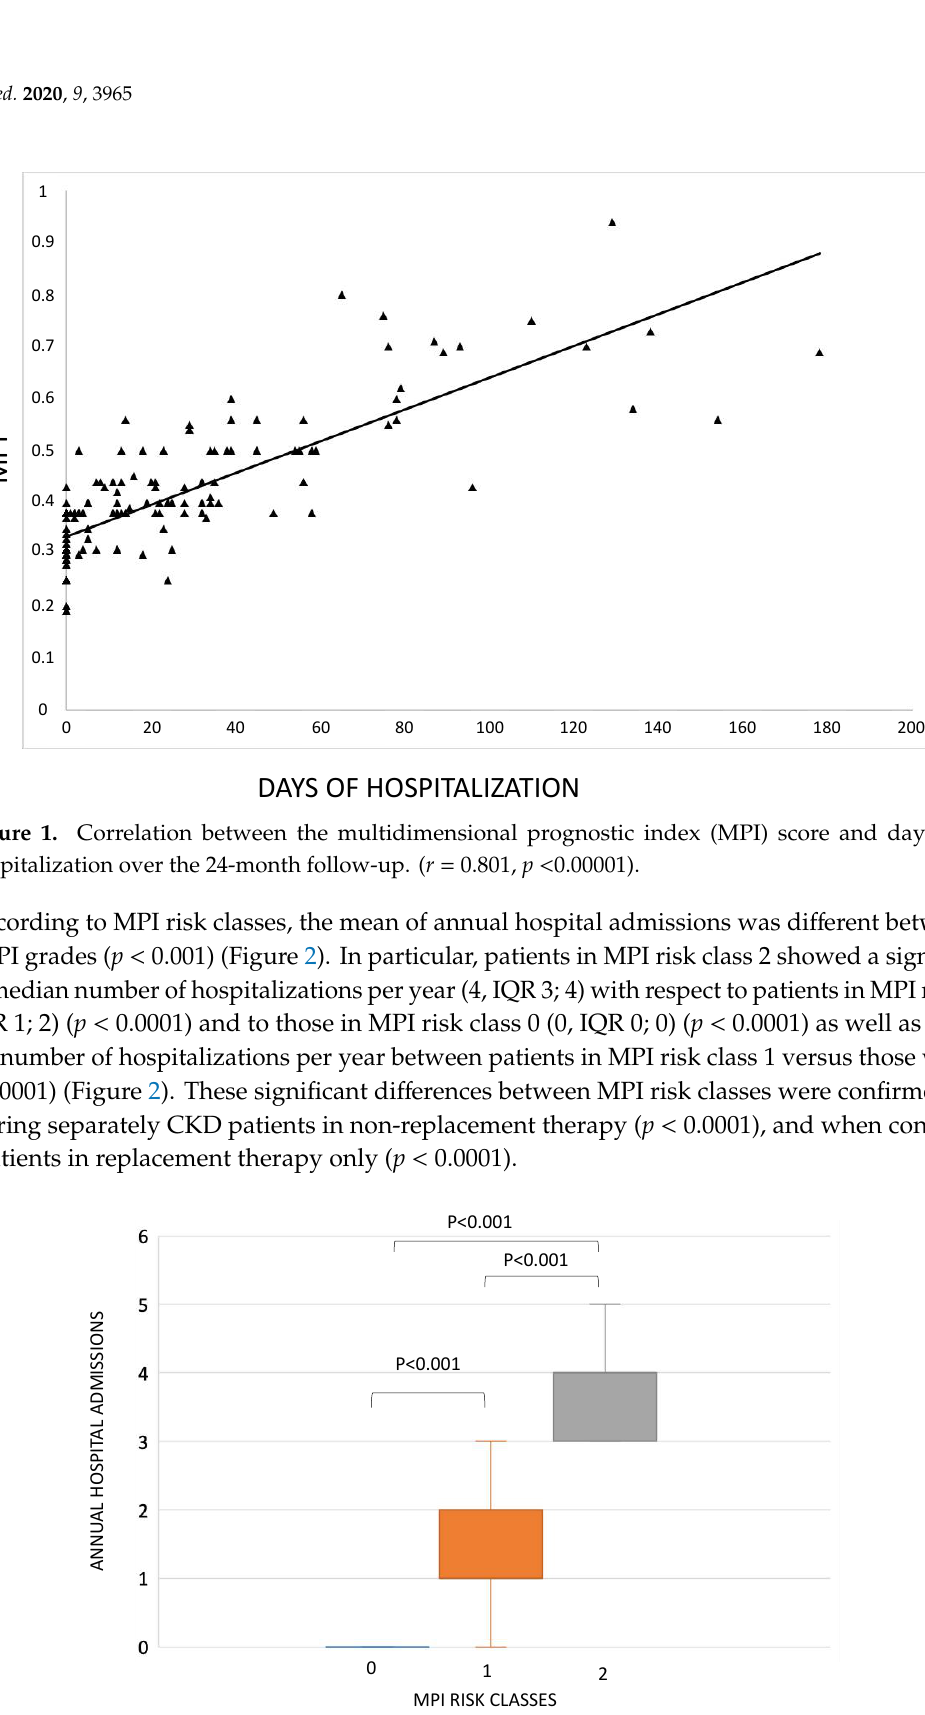
Figure 2. Di ff erences in annual hospital admission between multidimensional prognostic index (MPI) risk class 0 (0, IQR 0; 0), MPI risk class 1 (1, IQR 1; 2) and MPI risk class 2 (4 IQR 3;